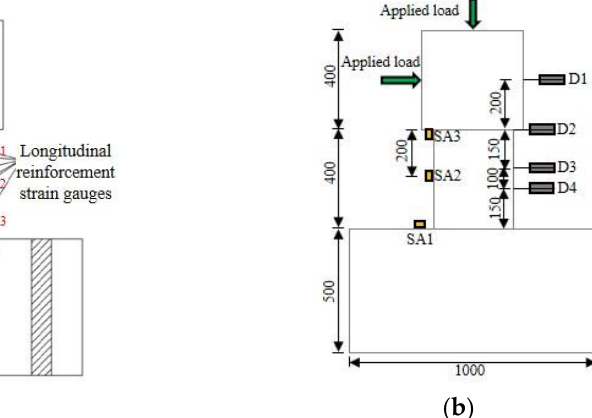
( b ) Figure 8. Test instrumentation. ( a ) The instrumentation for the strain gauges and LVDTs; ( b ) The instrumentation for SA transducers.